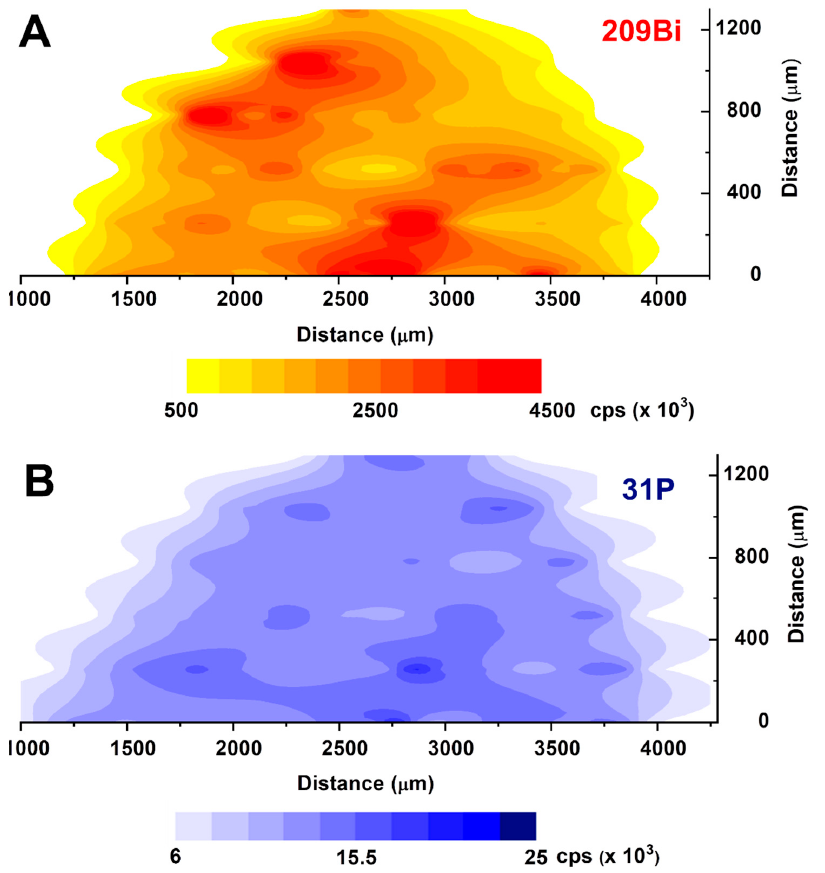
Figure 6. LA-ICP-MS contouring plots for 209Bi (( A ), top ) and 31P (( B ), bottom ) on a freshly prepared, untreated Bi/PO 4 /PSS electrode.